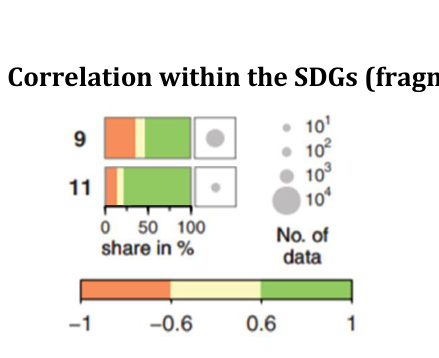
Source : Pradhan et al.